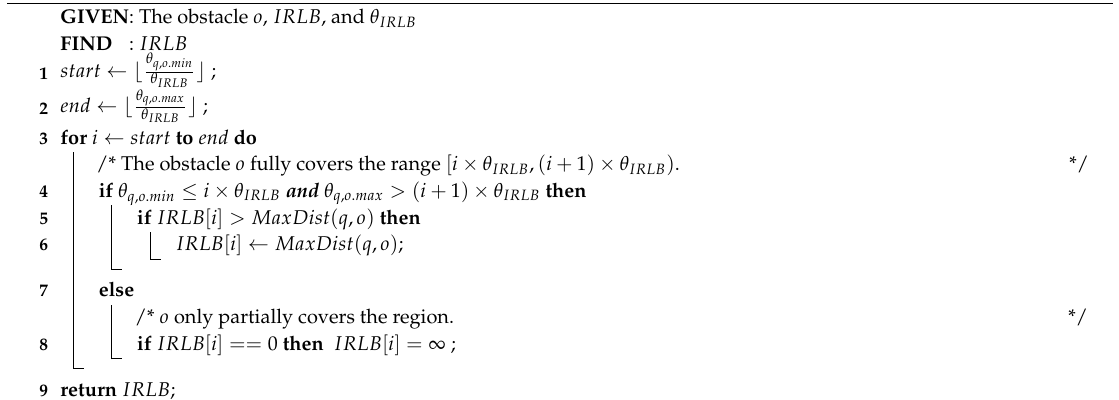
Algorithm 8. Insert an obstacle into an Invisible Regions Lookup Buffer (InsertToIRLB)